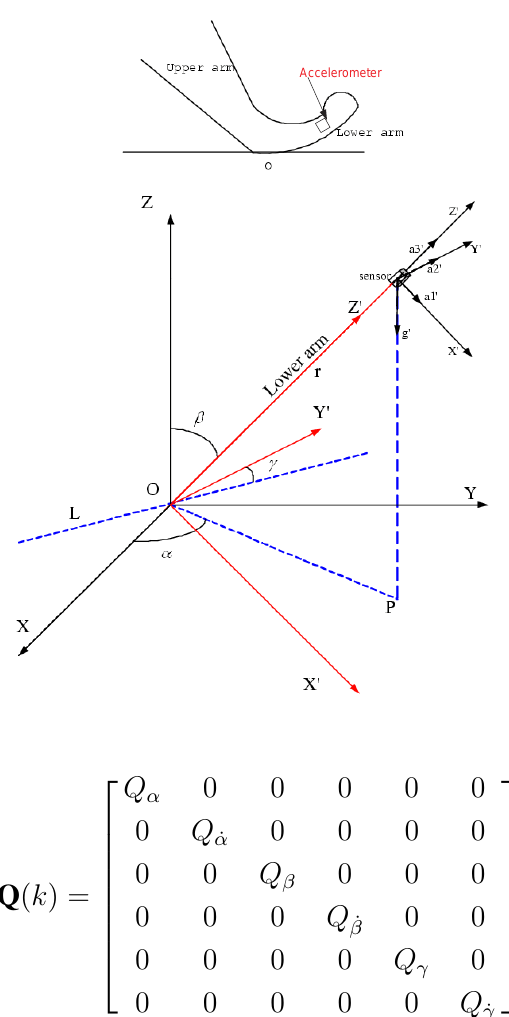
Figure 2. The 3-D arm movement system.